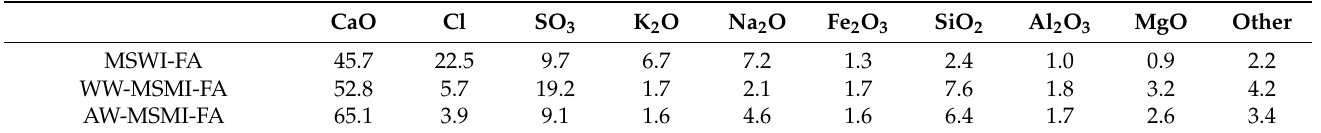
Table 5. Main elements of MSWI fly ash and upgraded ash by water washing (L/S = 6 mL/g)